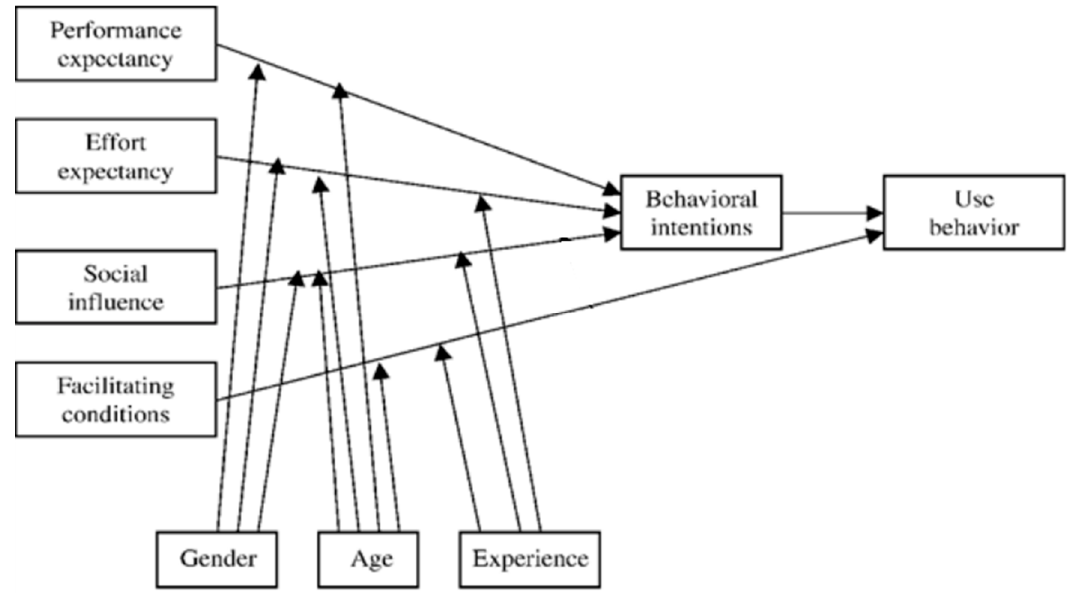
Figure 1. Unified Theory of Acceptance and Use of Technology (UTAUT) model used in the survey [18] with modifications matching the specifics of the Polish healthcare system (i.e., e-prescribing is mandatory in Poland, not voluntary) .